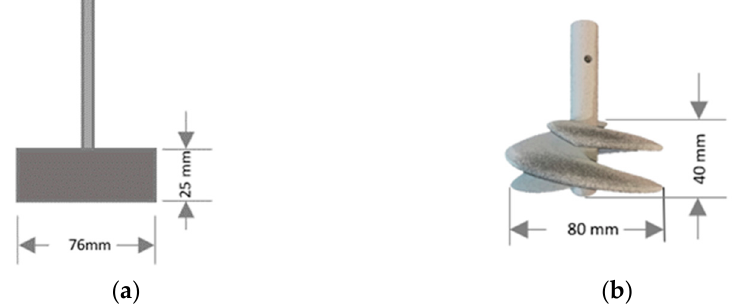
Figure 9. Geometries of mixing impellers: ( a ) flat mixer; ( b ) auger mixer.